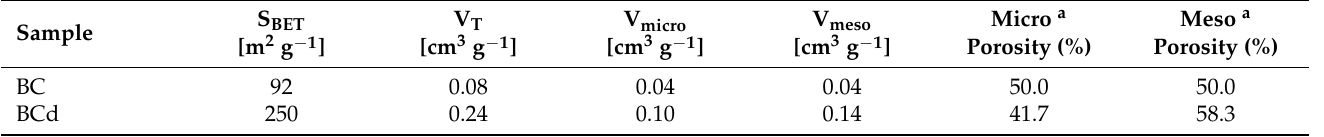
Table 2. The specific surface area and the porous structure characteristics of BC and BCd